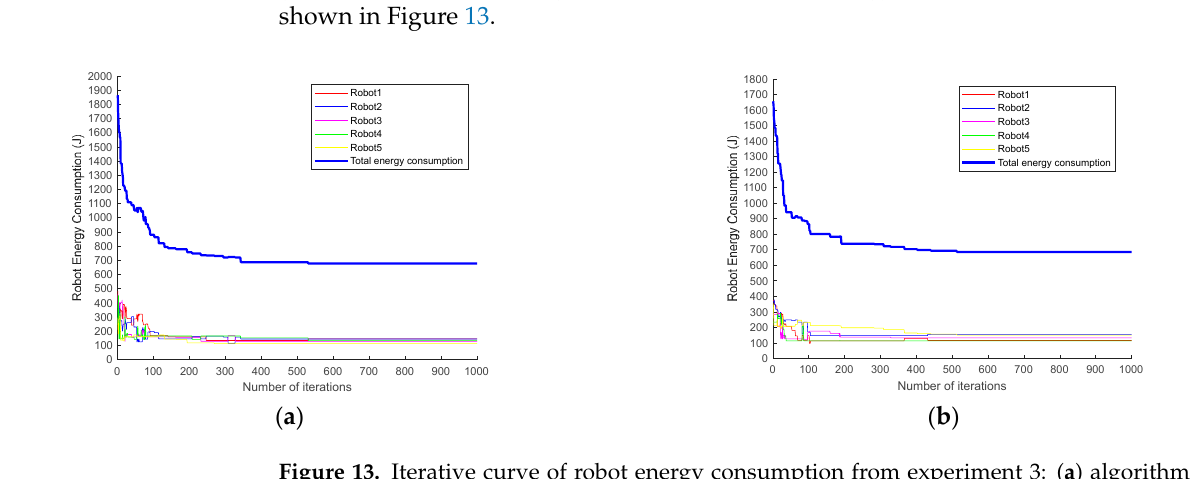
Figure 13. Iterative curve of robot energy consumption from experiment 3: ( a ) algorithm in this paper ; ( b ) penalty function and genetic algorithm .